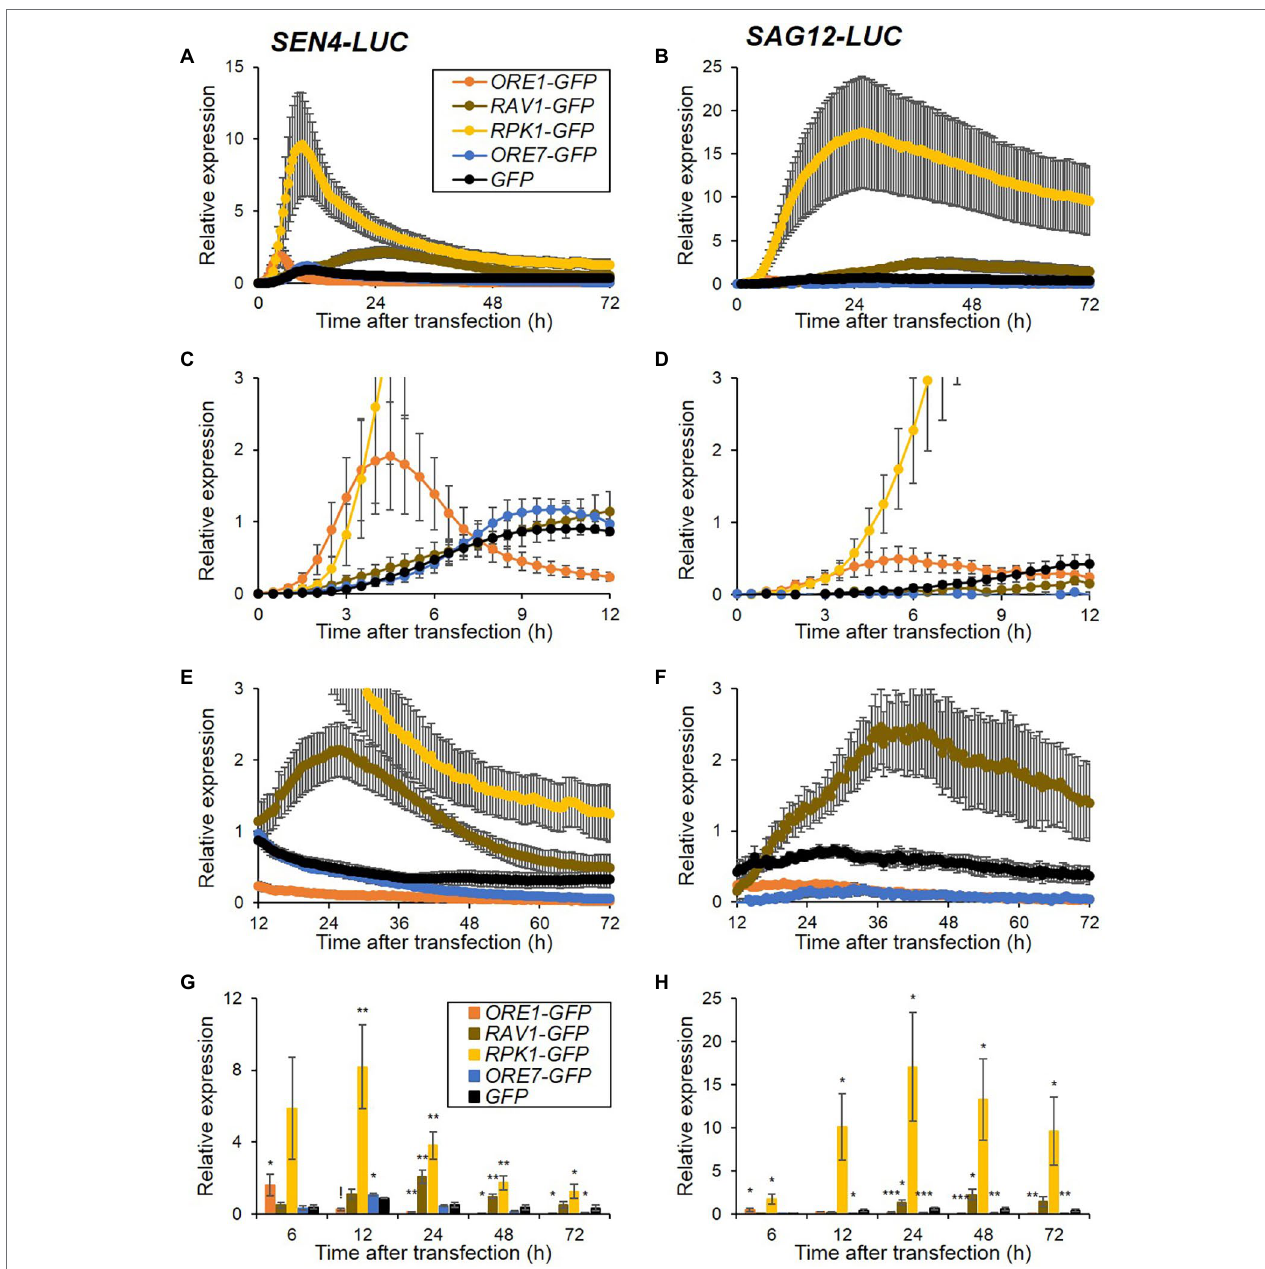
FIGURE 2 | Expression patterns of SEN4- (A) and SAG12-LUC (B) reporters by overexpression of senescence regulators. Arabidopsis protoplasts were co- transfected, as described in Figure 1 , but with overexpression effectors of GFP , ORE1- , RAV1- , RPK1- , and ORE7-GFP and either reporter of SEN4- or SAG12-LUC . (A–F) Bioluminescence traces of SEN4- or SAG12-LUC throughout the measurement (A,B) , and their traces with an adjusted scale at early (0–12 h; C,D ) and late (12–72 h; E,F ) time points are shown. Symbols in (B–F) are the same as in (A) . Luciferase activity of LUC was normalized to the maximum level of RLUC over the assay. Relative expression of SEN4- (A,C,E) and SAG12-LUC (B,D,F) was calculated by normalization to the maximum level of LUC/RLUC throughout the measurement in protoplasts transfected with GFP effector in each trial. (G,H) Relative expression of SEN4- (G) and SAG12-LUC (H) at 6, 12, 24, 48, and 72 h after transfection. Symbols in (H) are the same as in (G) . Data represent mean ± SE ( n = 6). A statistical analysis was performed using a two-tailed Student’s t -test (* p < 0.05; ** p < 0.01; *** p < 0.001; and ! p <